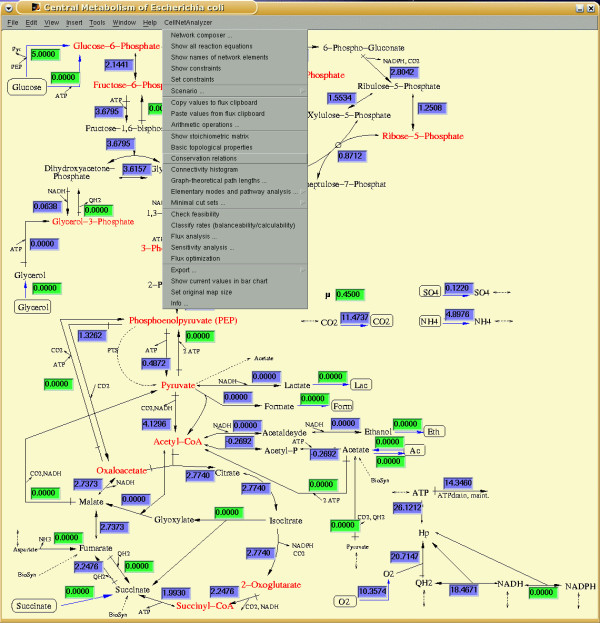
Example of an interactive network map of a mass-flow (metabolic) network in CellNetAnalyzer. The network shows the central metabolism of E. coli studied in [9]. The text boxes display a computed steady-state flux distribution (the numbers represent reaction rates). Green boxes indicate rates fixed prior computation and blue boxes show calculated rates. The pull-down menu of CellNetAnalyzer (for mass-flow networks) is also shown.